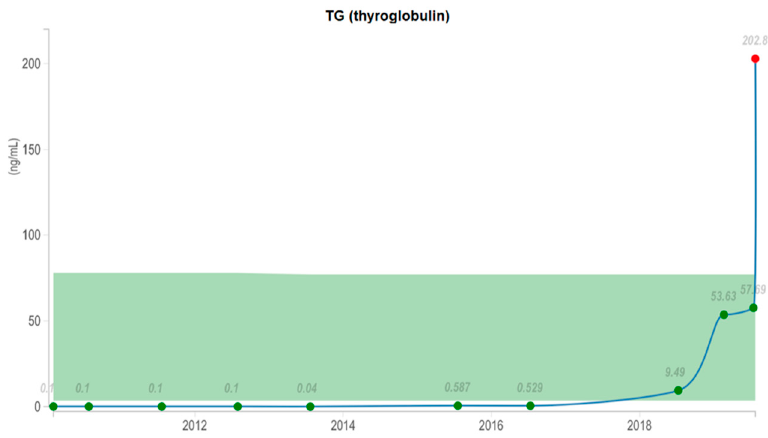
Figure 3. Thyroglobulin (TG) level dynamics (2010–2019). At the ending of 2018 TG level started to rise, in 2019 reaching a maximum level of 202.8 ng/mL.